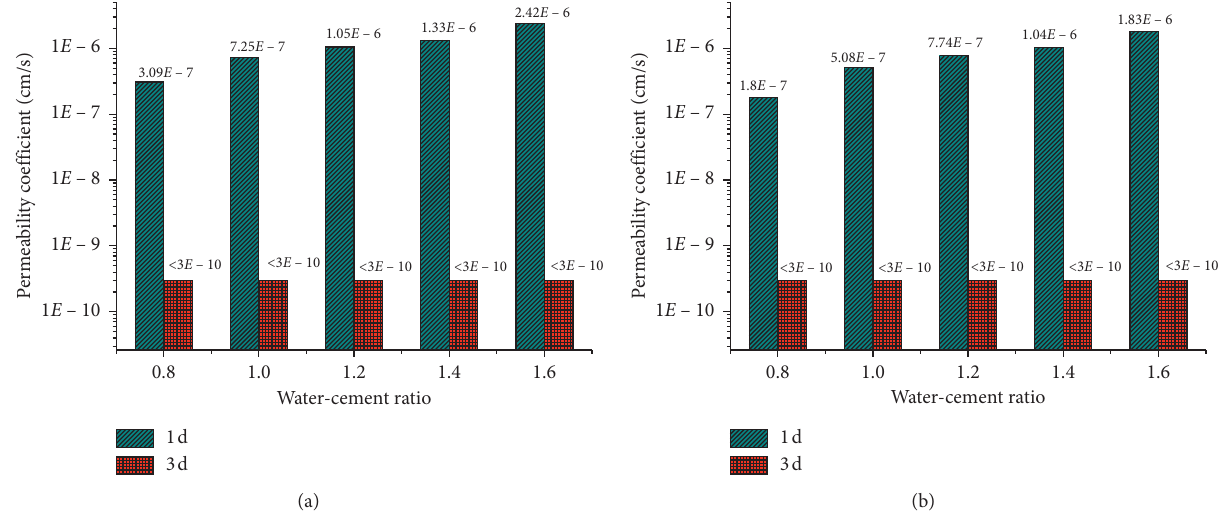
Figure 10: Variation of permeability coefficient of the grouted body with curing time. (a) d � 0.63–2.5mm. (b) d �